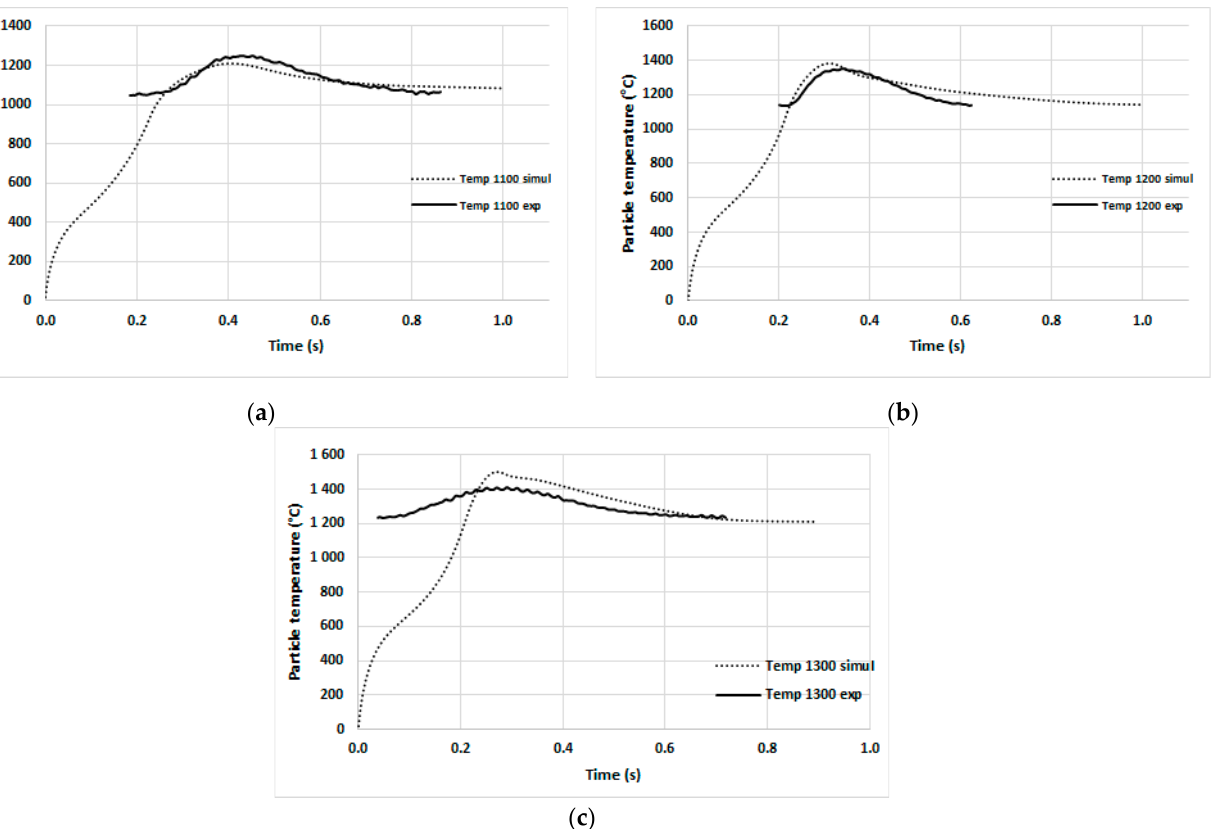
9 of 19 Table 2. Initial values of the parameters involved in the model. Experimentally Determined Values